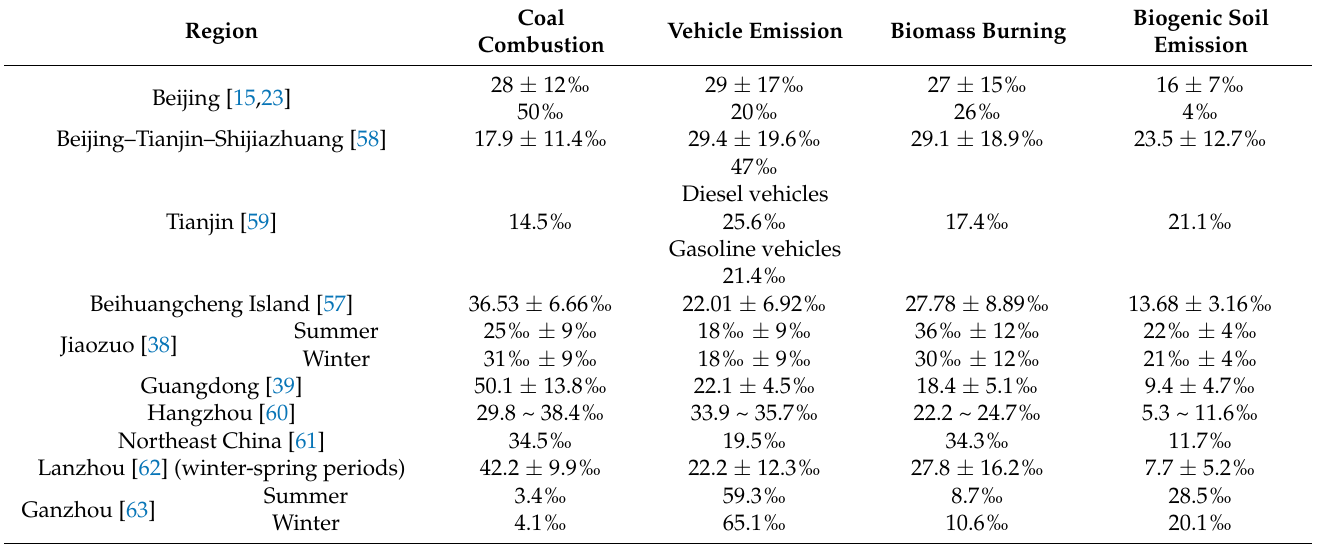
Table 1. Sources of NO X in different